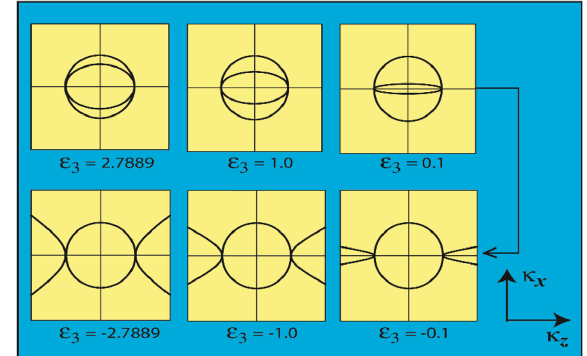
Figure 2. Cross-sections through the ( j x, j z )-plane in wavenumber space when j y = 0 and the optic axis lies along the j z -axis. The figure shows the transition from anisotropic (ellipse) to hyperbolic as e 3 changes in incremental steps from a positive to a negative value. The element e 1 = e 2 = 4.0.